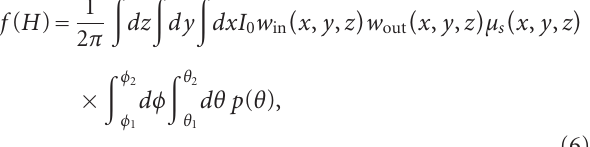
Figure 3: Simulation setting for imaging based on small-angle scattering